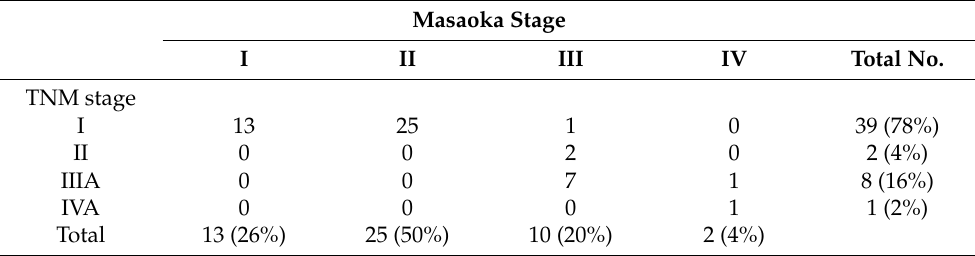
Table 2. Classification according to tumor, node and metastases (TNM) and Masaoka–Koga staging